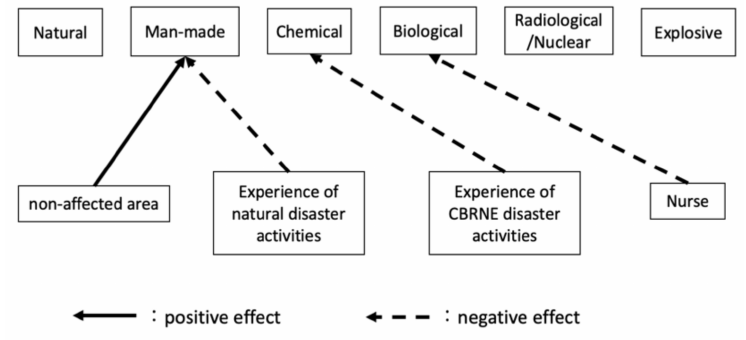
Figure 1. A path diagrammatic representation of the impact of background factors on intent to engage for each hazard. The solid and dashed lines represent a significant positive and negative impact on engagement intent score,